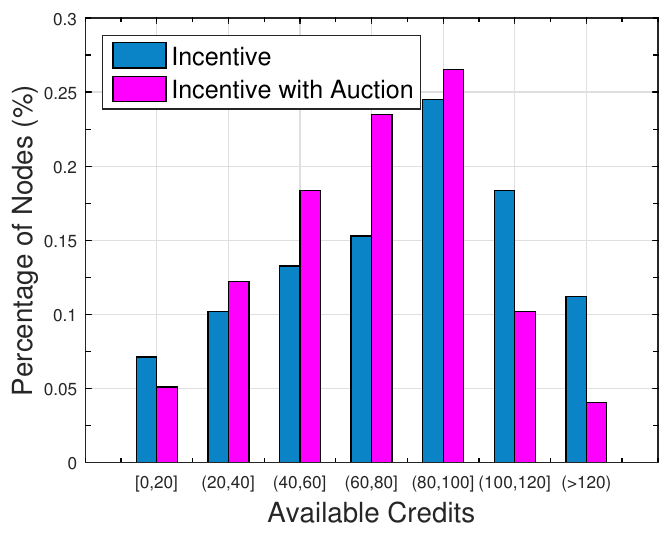
Figure 2. Distribution of available credits.